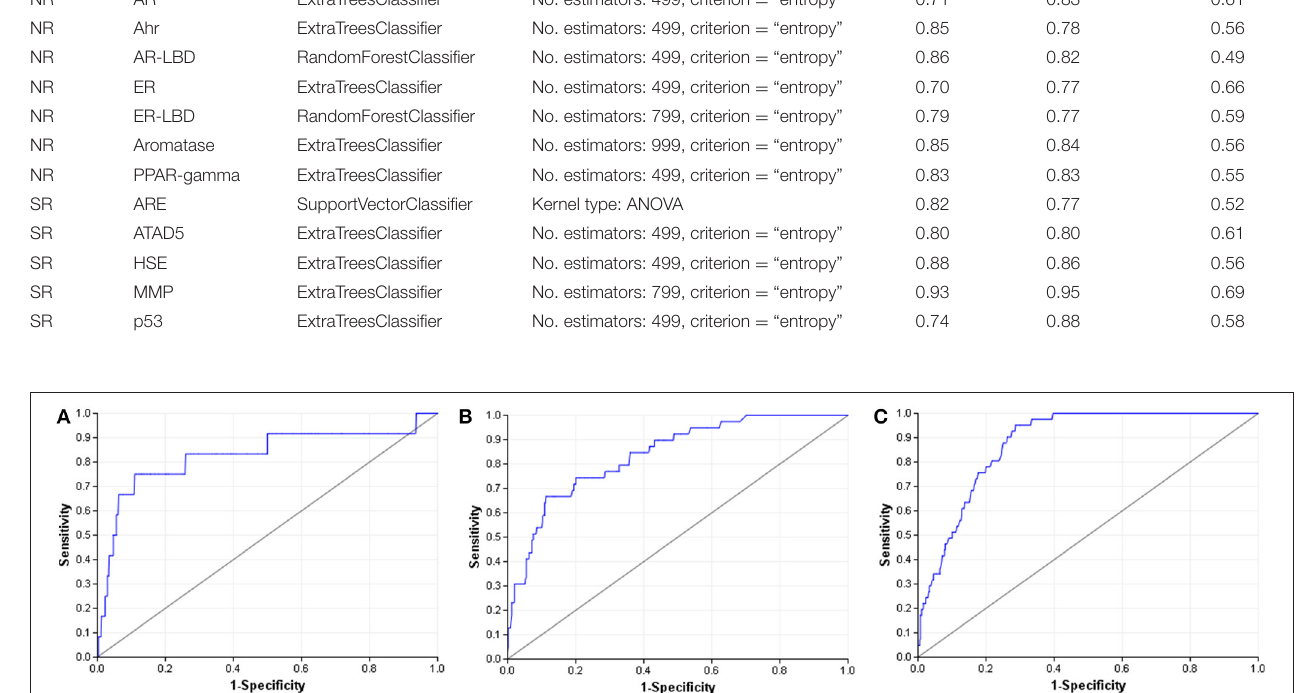
TABLE 3 | Comparison of leaderboard and final performance on all assays. Panel